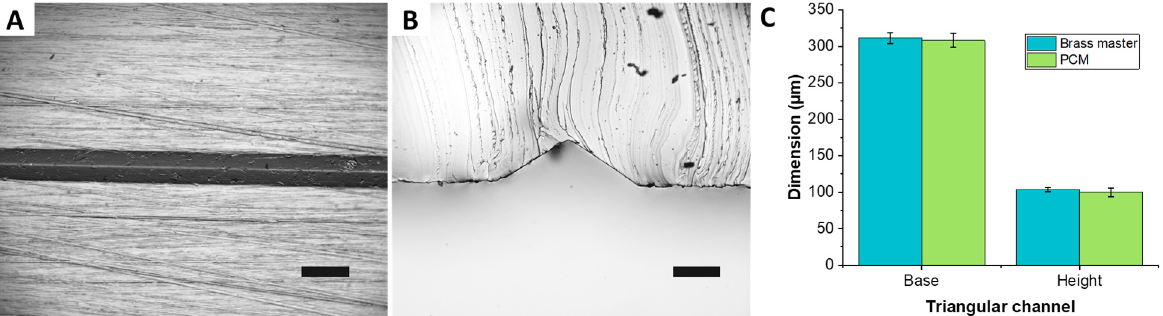
Figure 4. Replication of triangular channels. PDMS replicas of triangular micro channels formed from PC master; PC has been molded on a PDMS replica of a micromilled brass plate patterned with a 100 µm deep, 300 µm wide triangular channel (~113° apex). ( A ) Top view of the triangular channel; scale bar is 500 µm. ( B ) Cross section of the channel; scale bar is 100 µm. ( C ) Quantitative comparison of channels base and height with respect to the replica of the original master ( n = 5).